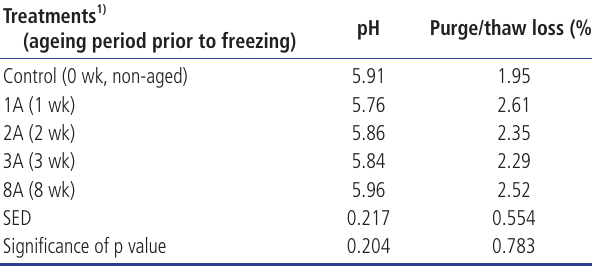
Table 1. pH and purge/thaw loss of aged/frozen/thawed lamb loins Treatments 1) (ageing period prior to freezing)